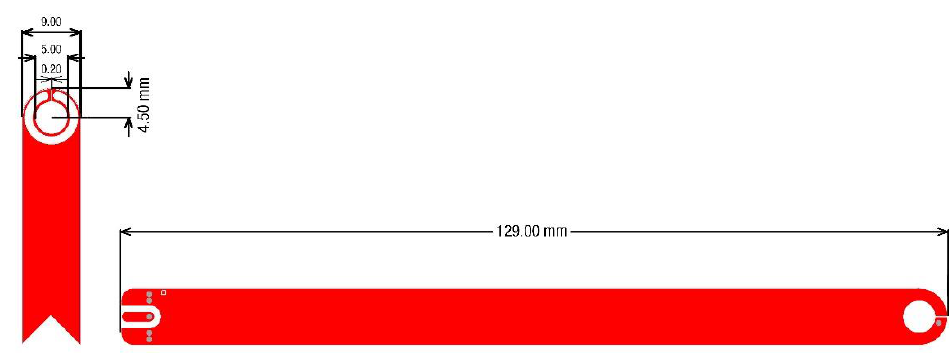
Figure 3. Dimensions of the designed NFP PCB.